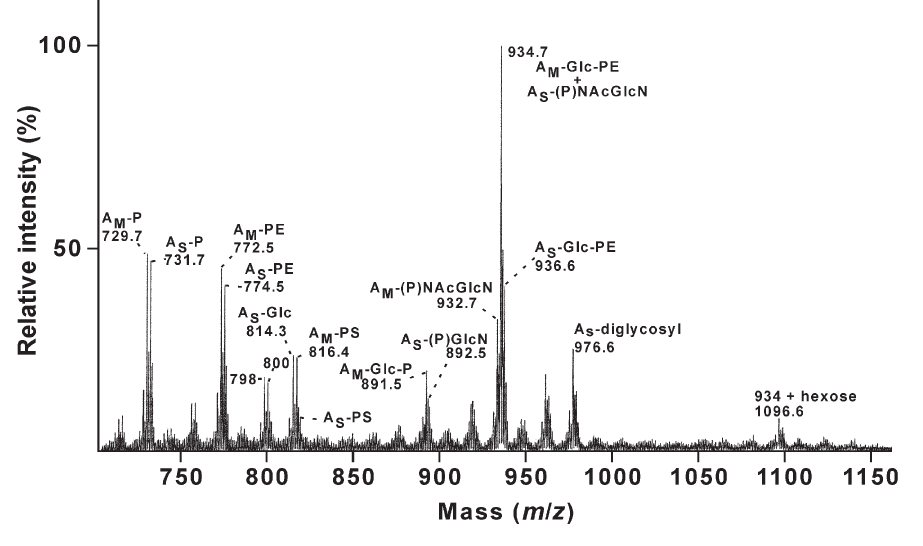
Figure 3. Negative-ion FAB MS spectrum of the total polar lipids of Methanococcus jannaschii . Assignments are shown in the figure and remain tentative for m / z = 891.5, 932.7, 1096.6 and A S - (P)NAcGlcN, not reported pre- viously (Ferrante et al. 1989). (P) = position of phosphate un-